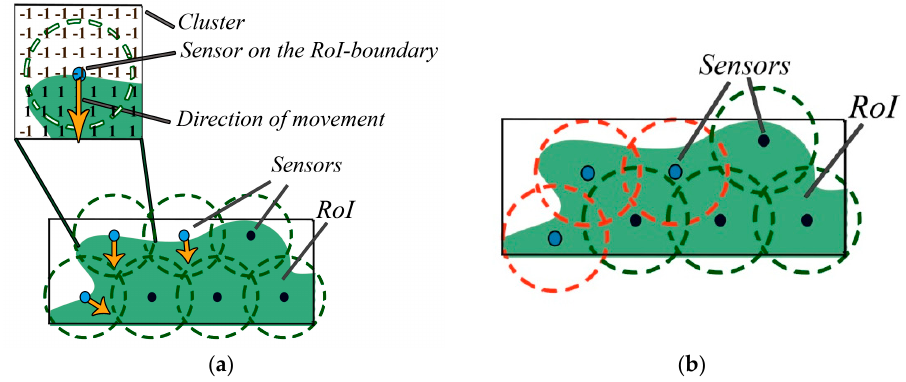
Figure 9. Positions of the sensor nodes on the boundary: ( a ) before and ( b ) after applying the gradient method.